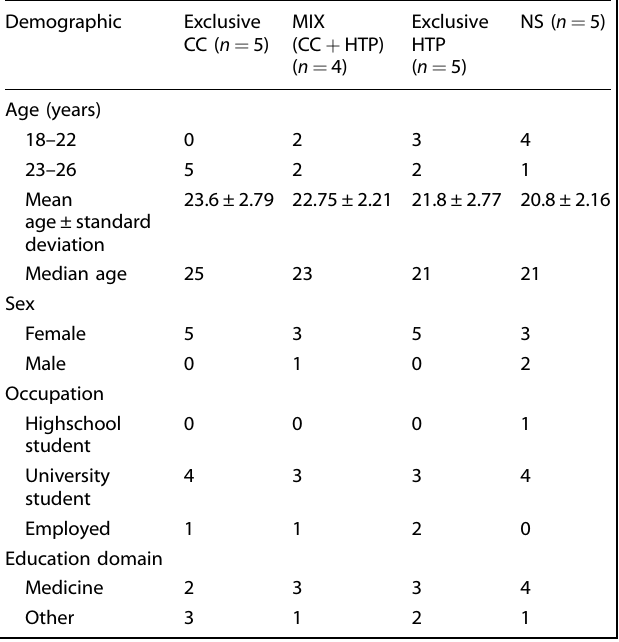
Table 1. Participant ’ s characteristics.